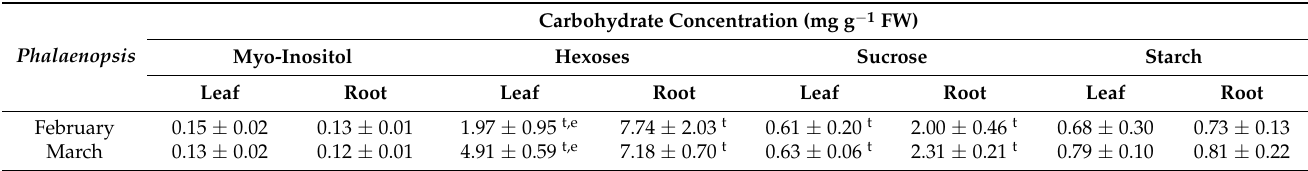
Table 3. Carbohydrate concentration in pooled samples of Phalaenopsis plantlets. Data are mean ± SD ( n = 4).